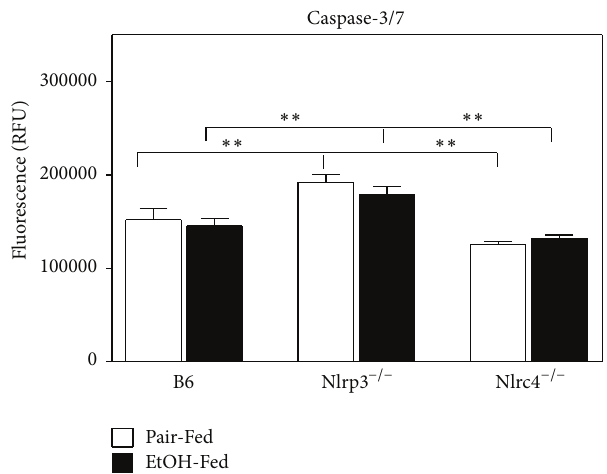
Figure 8: Increased caspase-3/7 in the liver of Nlrp 3 −/− mice. Protein was isolated from C57BL/6J (B6), Nlrp 3 −/− , and Nlrc 4 −/− mice fed Lieber-DeCarli ethanol-containing diet (EtOH-Fed) or pair-fed controls (Pair-Fed). Expression of hepatic caspase-3/7 was measured as relative fluorescence. The values are the means ± SEM for 𝑛 = 4 –6 mice per group. Values represent the mean ± SEM with ∗∗ 𝑃 < 0.05 , ∗∗∗ 𝑃 < 0.001 by Student’s 𝑡 -test for 𝑛 = 4 –6 mice per group.